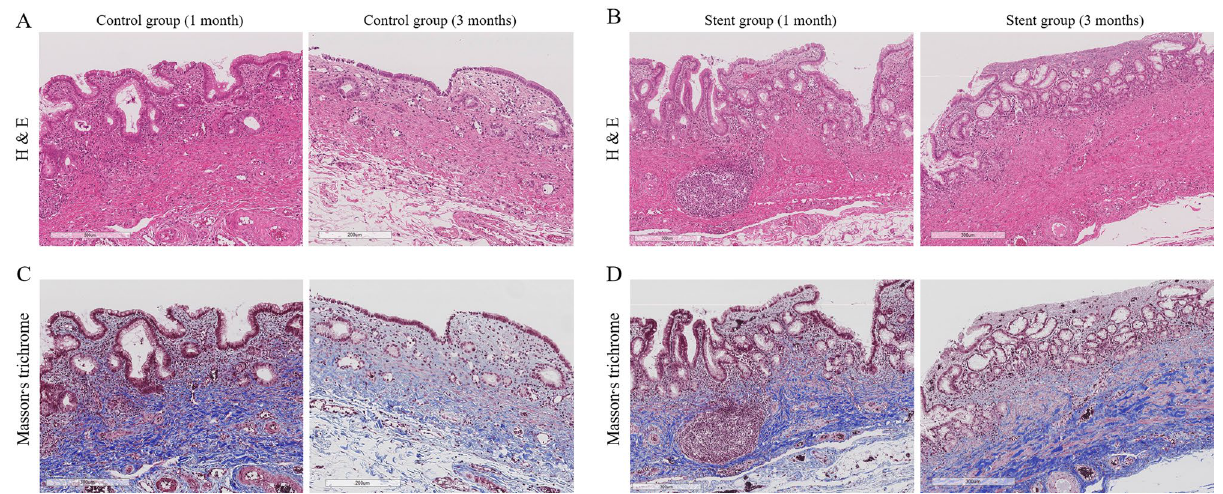
Figure 8. H&E and Masson’s trichrome staining of common bile ducts (CBD) from the control and stent groups. ( A , B ) H&E staining shows more mucinous gland hyperplasia and lymphoplasmacytic infiltration in the CBD of stent group than that of control group. ( C , D ) Masson’s trichrome staining of the CBD shows more prominent fibrosis (blue-colored staining of the collagen fibers) in the stent group than in the control